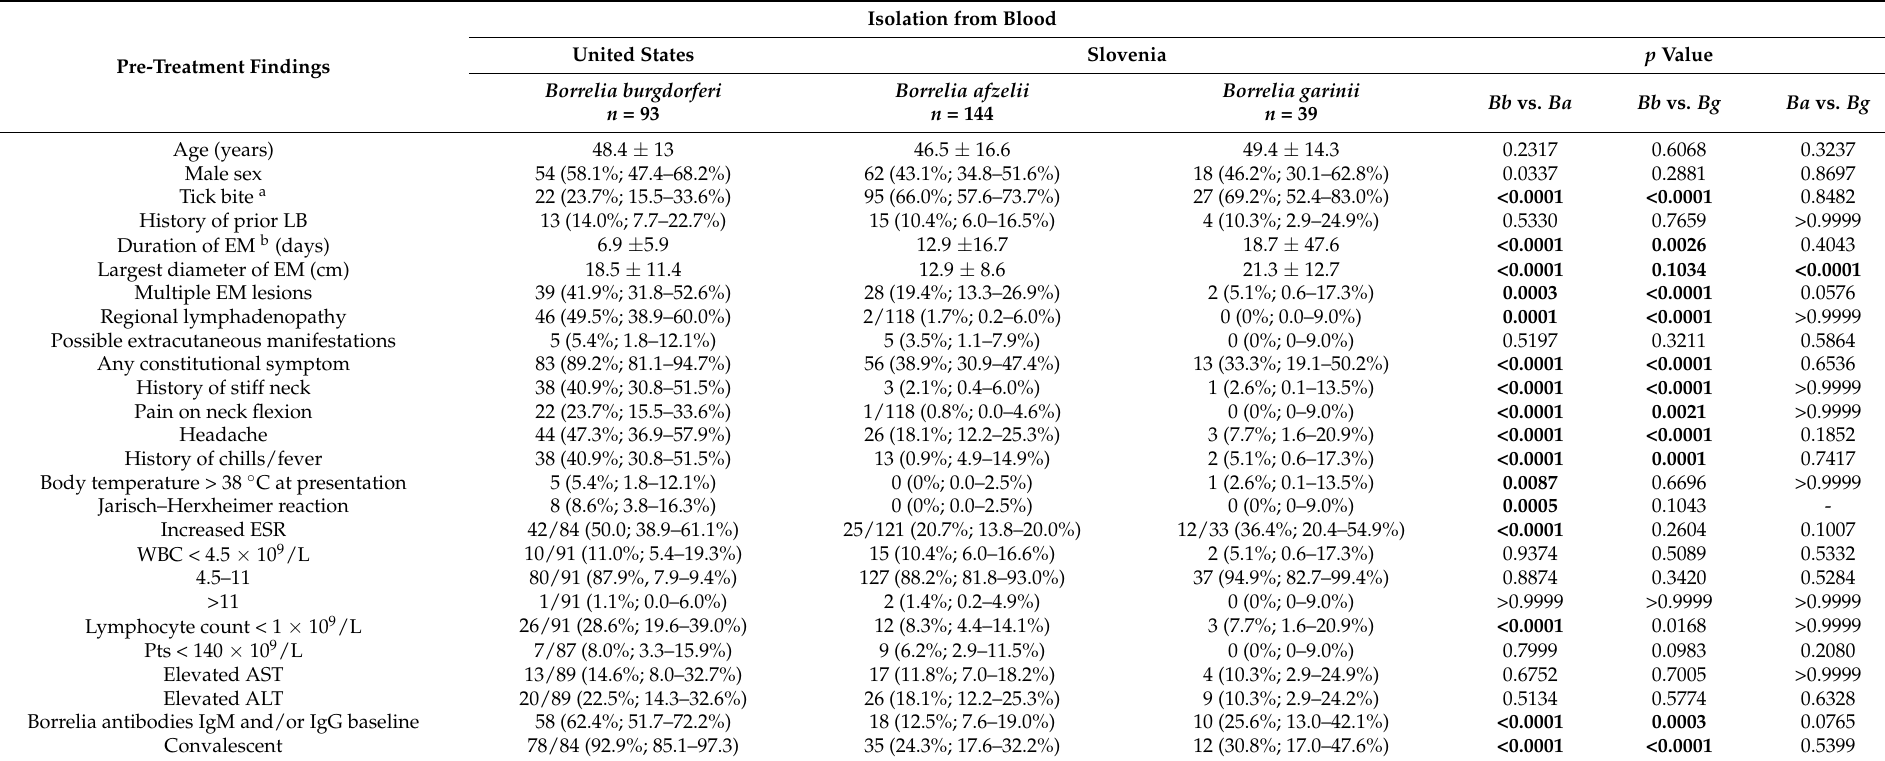
Table 1. Comparison of Selected Demographic, Clinical, and Laboratory Features of Patients with Erythema Migrans Who Had a Positive Blood Culture for Borrelia burgdorferi (No = 93), Borrelia afzelii (No = 144) or Borrelia garinii (No =